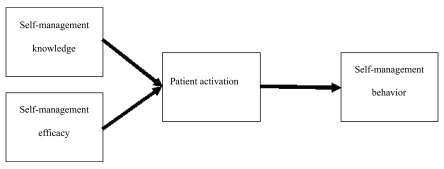
Patient activation concept framework.